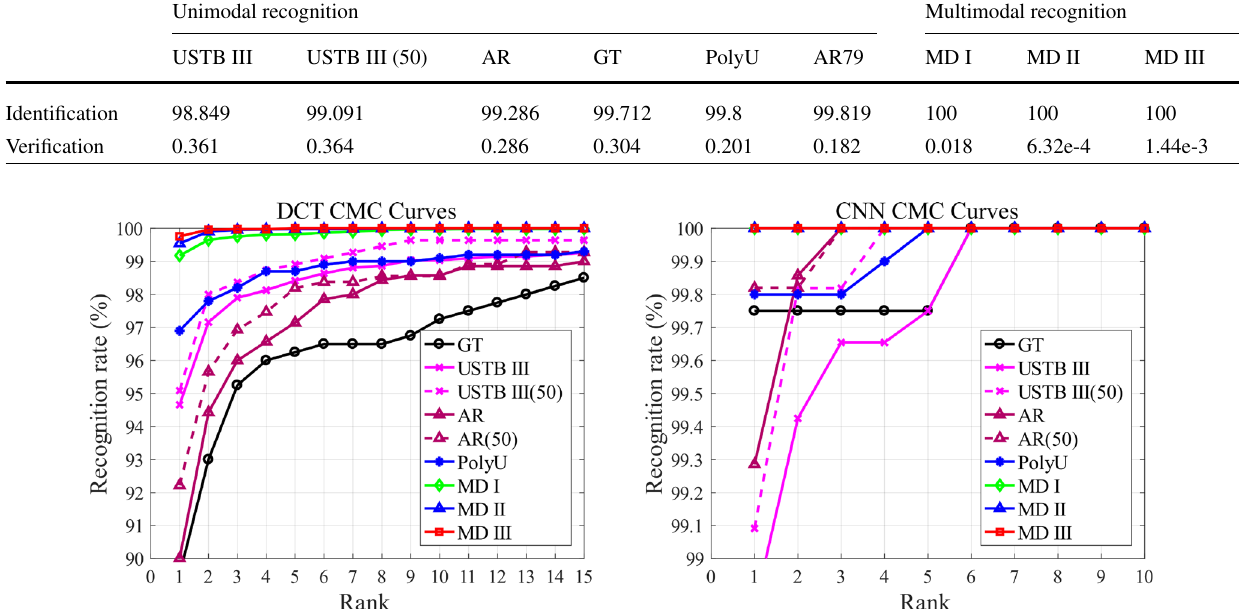
Fig. 13 CMC curves of SRC-based identification using DCT features (upper) and CNN features (lower) on all the datasets